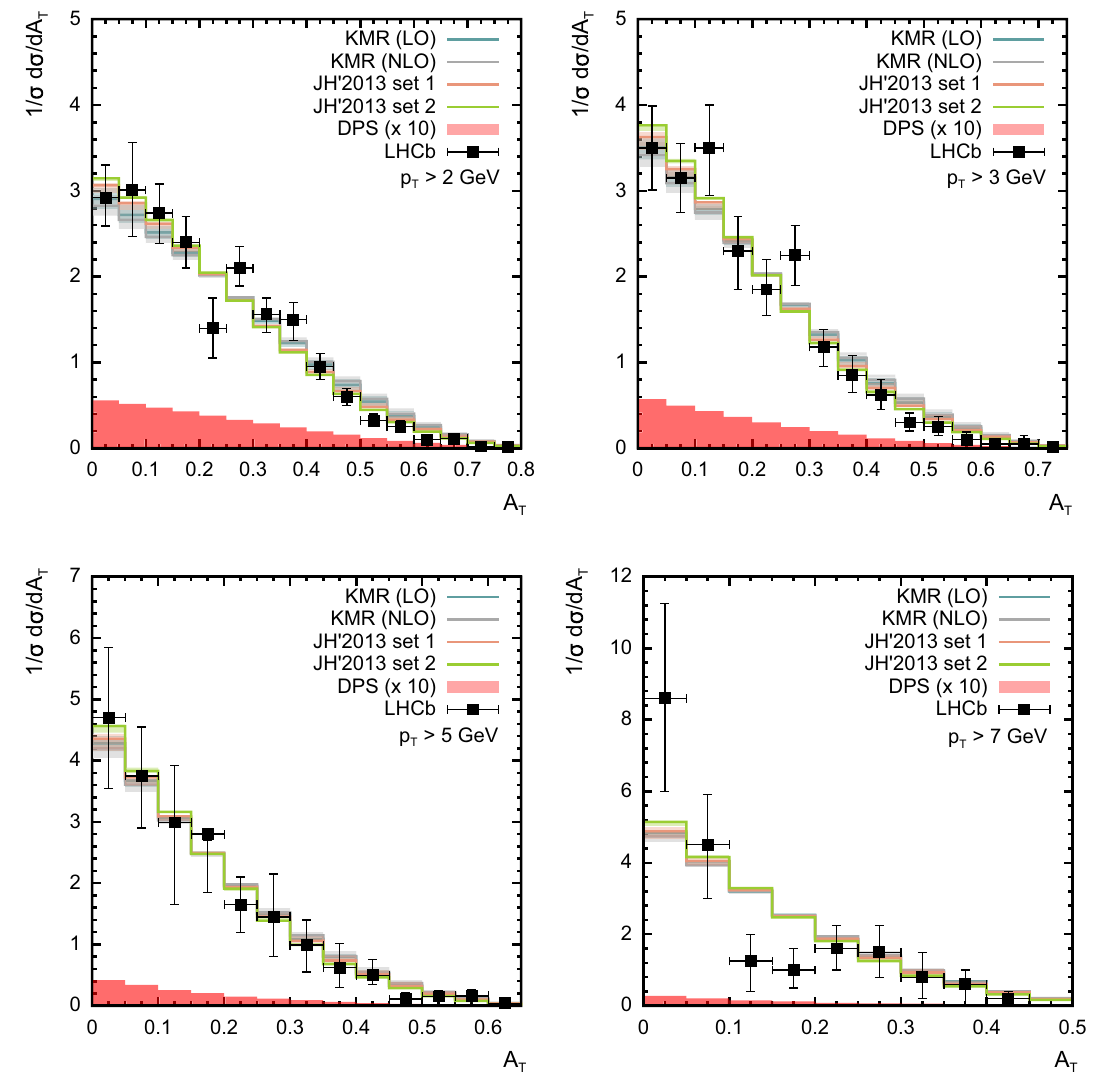
√ s = 8 TeV as a function of assymetry A T between